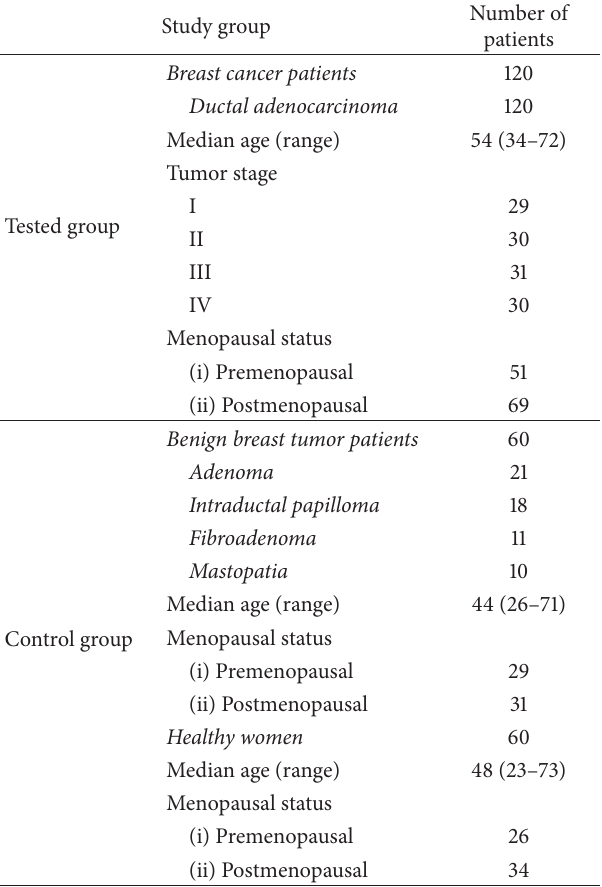
Table1:Characteristicsofbreastcancerpatientsandcontrolgroups: benign breast tumor and healthy